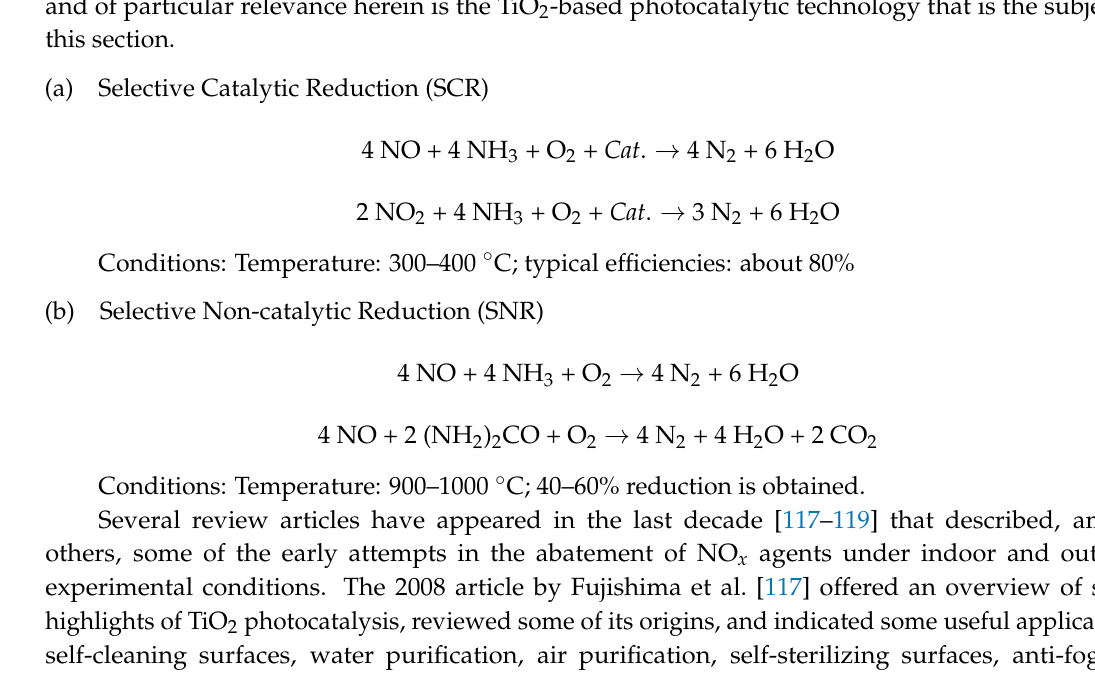
Figure 28. Global average NO x emissions from various sources in 2015 in kilo tonnes (kt) per million tonnes oil equivalent (Mtoe). Plot made from selected data from the International Energy Agency [115].